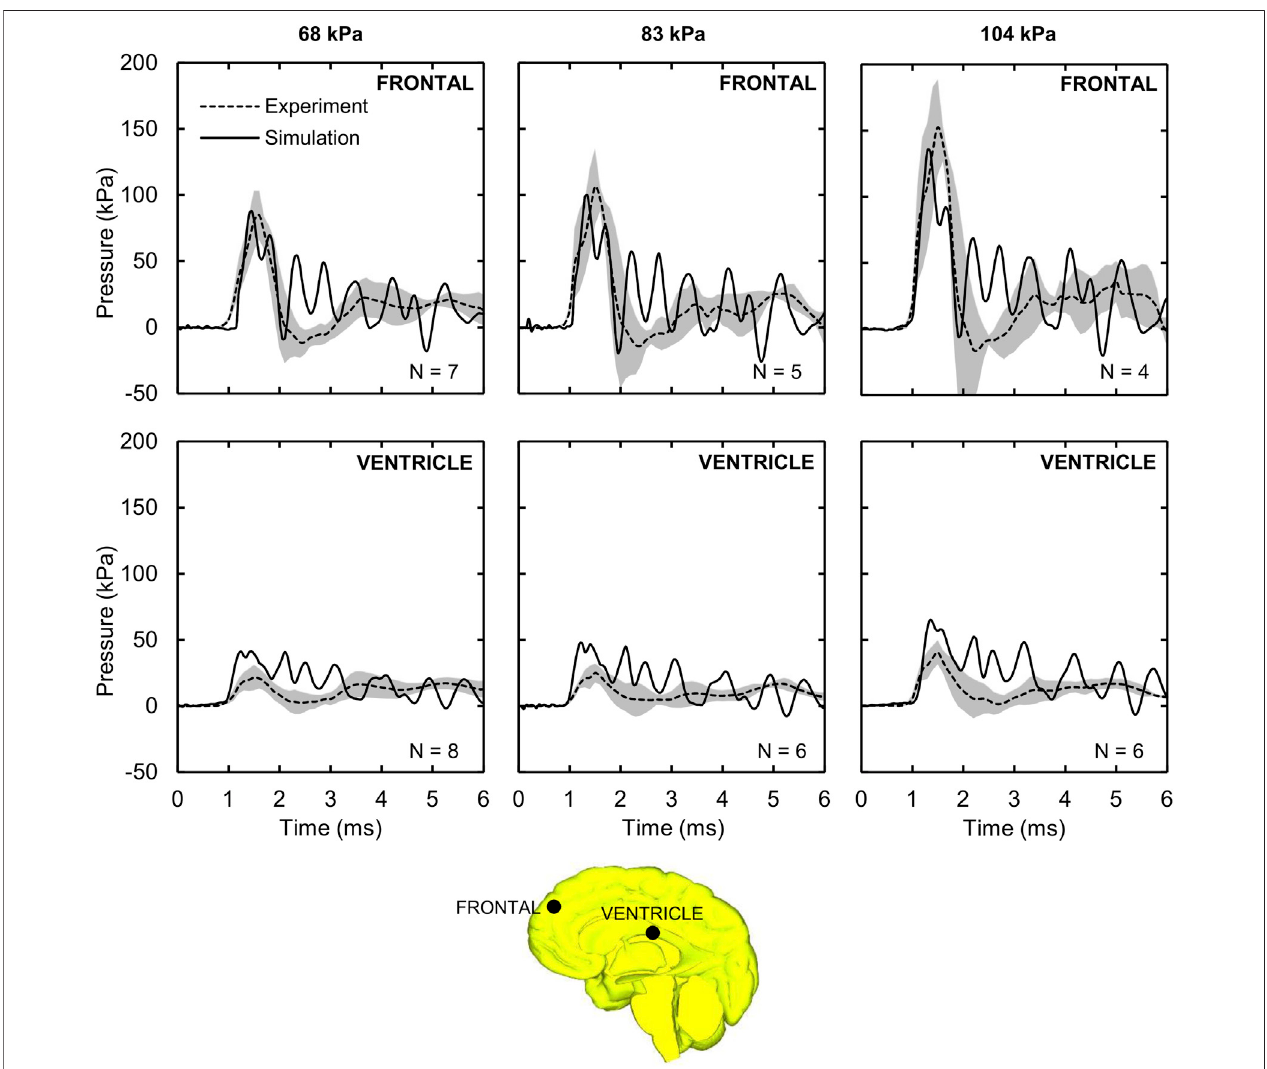
FIGURE3| Intracranialpressure(ICP) measured intheshock-tube experiment andpredicted bythedetailed-vasculature model.Shown arethetemporalpro fi leof thepredicted(solidlines)andexperimentallyobserved(dashedlines)ICPvaluesatthefrontallobeandventricleforthe68,83,and104 kPablastoverpressures.Shaded regions; mean ± two standard errors of the mean. (Locations selected for comparison are indicated by black circles on the mid-sagittal brain geometry.).